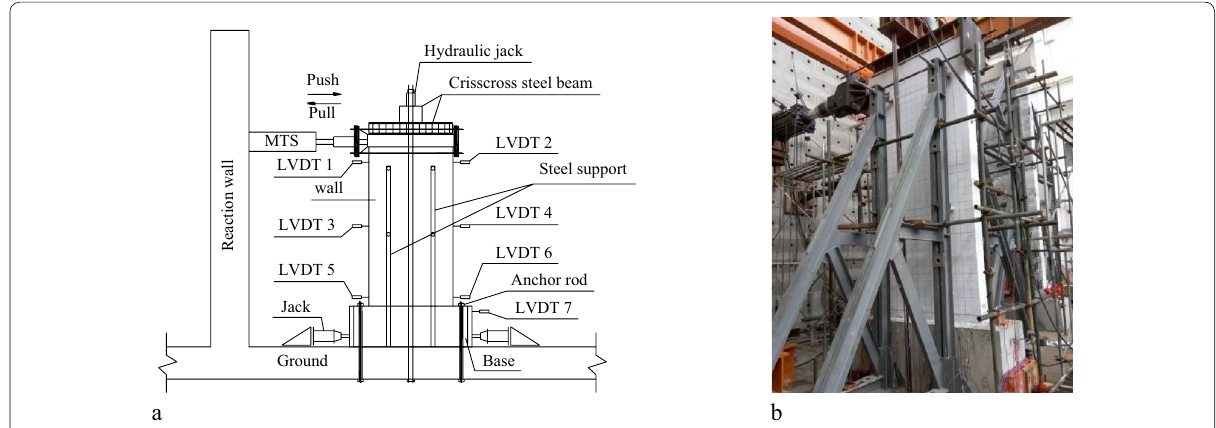
Fig. 4 Test setup: a schematic; and b